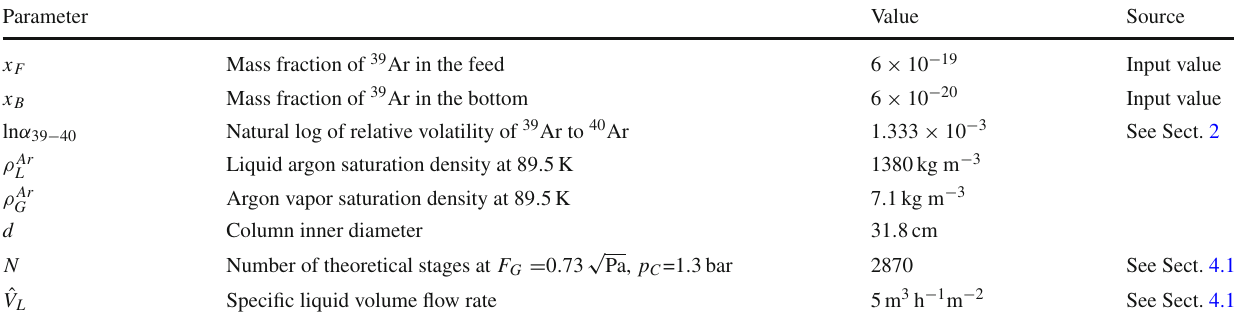
Table 2 Input parameters of the calculation of 39 Ar– 40 Ar distillation with the McCabe–Thiele method Parameter Value Source x F Mass fraction of 39 Ar in the feed